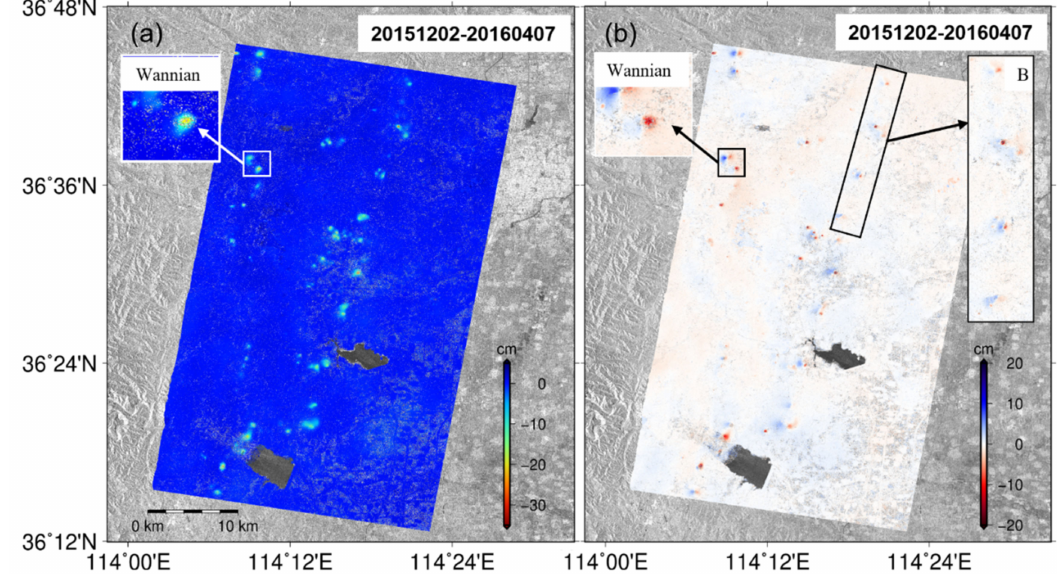
Figure 9. ( a ) The subsidence map and ( b ) horizontal displacement map of the Fengfeng mine area with TerraSAR–X and Sentinel-1A from 20151219 to 20160407.